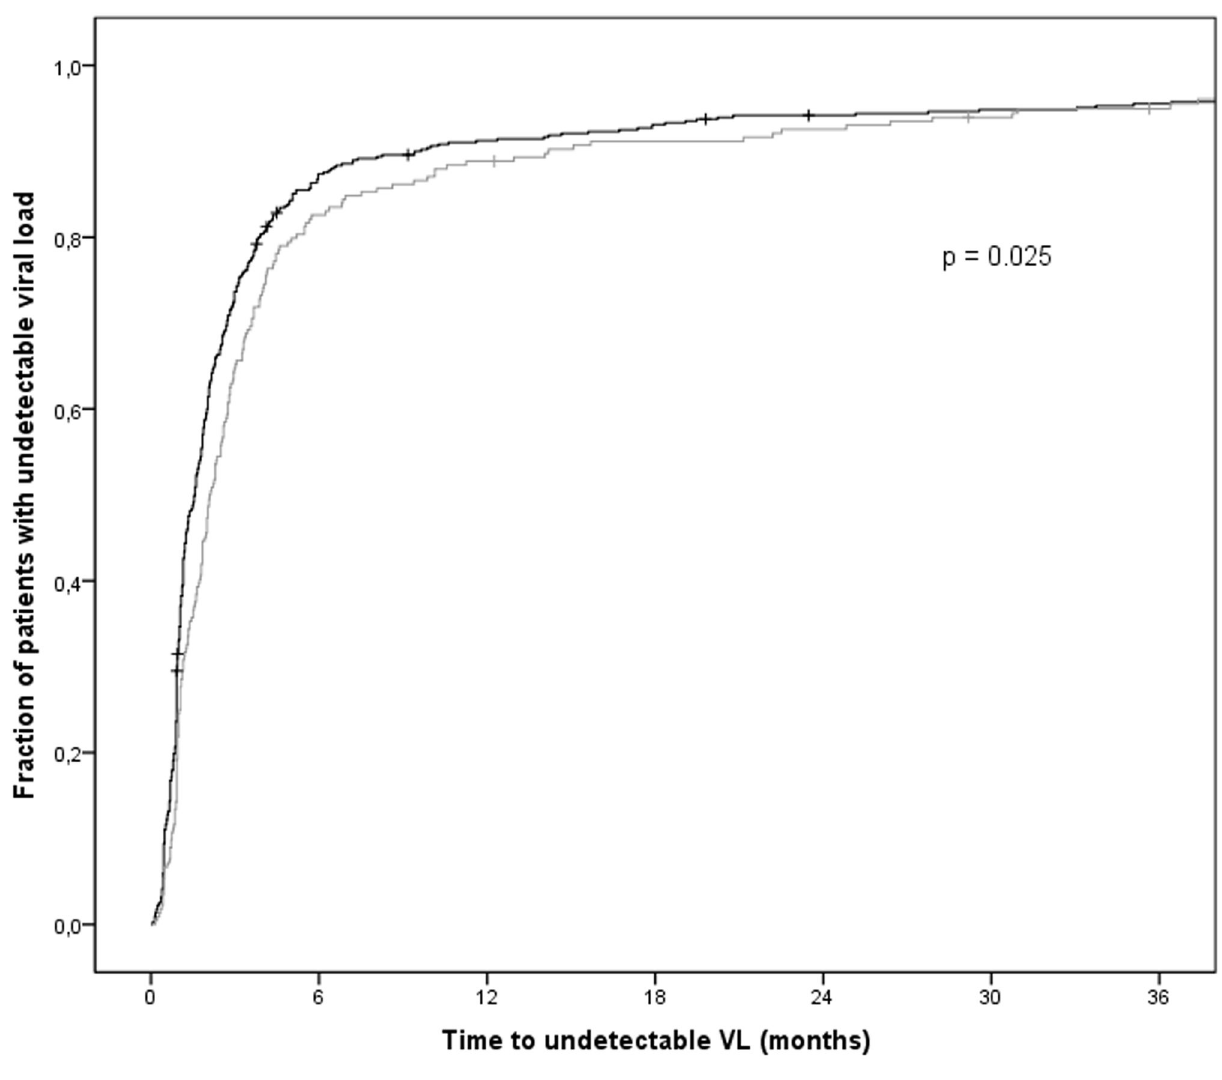
Figure 1. The presence of X4-HIV variants prior to cART is associated with a delay in time to viral suppression. Kaplan- Meier survival analysis for time to reach an undetectable viral load after initiation of cART. The black line represents patients with no detectable X4-HIV variants at baseline (n=508), the grey line represents patients with X4-HIV variants at baseline (n=224). Of the 732 patients in the analysis, 13 were censored (annotated by +) due to loss of follow-up (n=7) or death (n=6). At the end of the 3 year follow-up period, 27 patients had not yet reached viral load below the detection